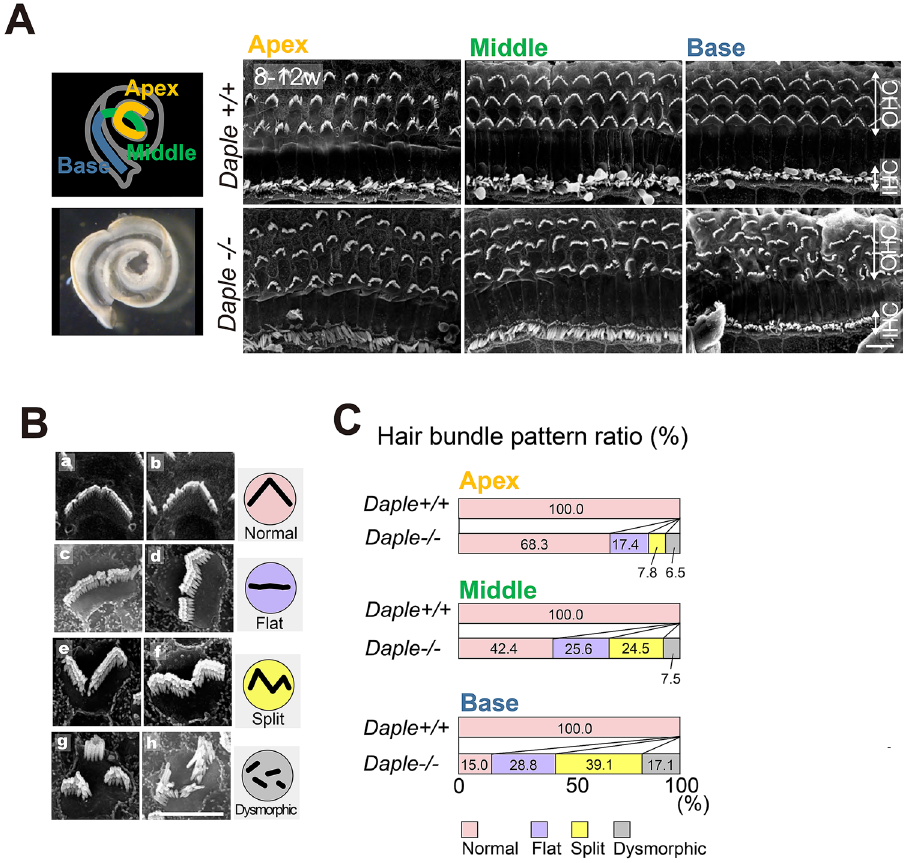
Figure 2. Scanning electron microscopy (SEM) analysis of Daple-deficient organ of Corti (OC) in adult mice. ( A ) SEM images of hair cells (HCs) from apex, middle, and basal areas of Daple +/+ and Daple −/− cochleae in adult mice. Daple −/− cochleae exhibit major abnormalities in hair bundles in OHCs, high magnification images of OHCs. ( B a, b) Daple-/- HCs with normal bundles. ( B c, d) Daple −/− HCs with flat bundles (jagged horizontal line). ( B e, f) Daple −/− HCs with split bundles (reversed apex region of the V-shape bundle). ( B g, h) Daple −/− HCs with a generally deformed bundles (dysmorphic bundle; fragmented bundle). Scale bars: A; 10 μm, B–G; 5 μm. ( C ) Analysis of the difference between Daple + / + and Daple −/− mice in the three cochlear areas (apex, middle, and basal areas), (8–12-week-old, Daple + / + apex 91 cells, middle 95 cells, and basal 94 cells, Daple −/− apex 632 cells, middle 477 cells, and basal 455 cells). The ratios of Daple-deficient mouse HCs tended to increase with some deformed